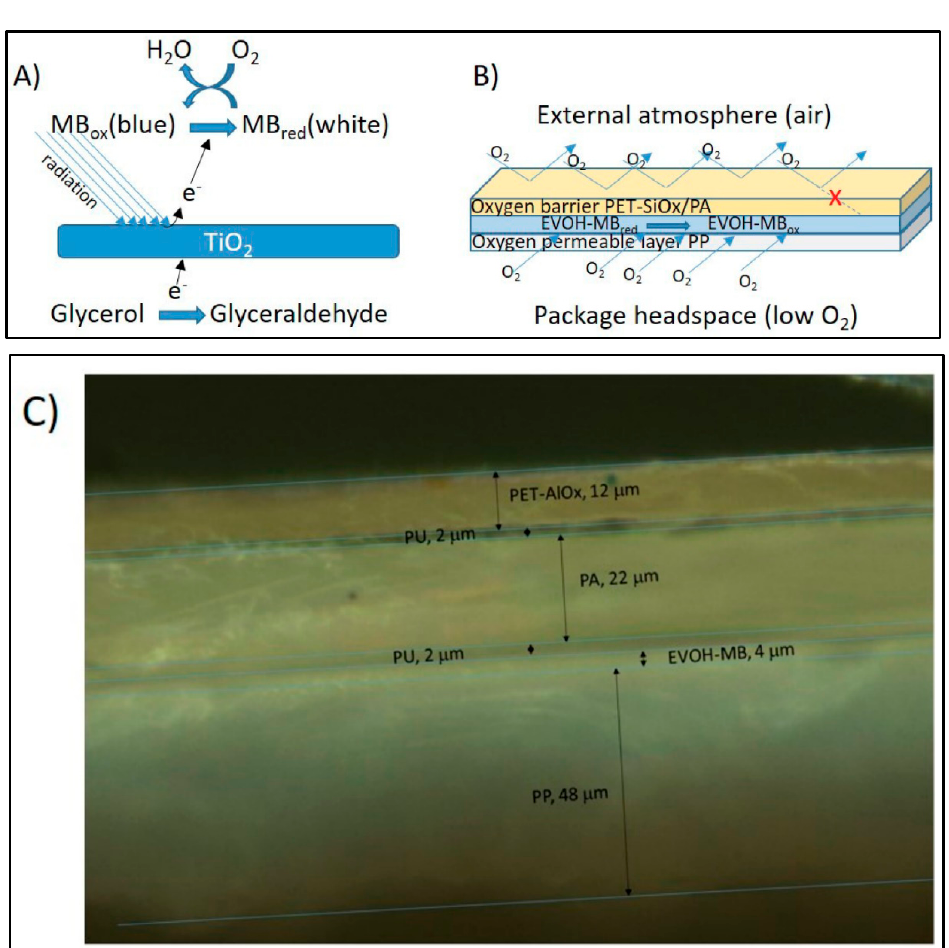
Figure 9. Schematic mechanism of O 2 detection. ( A ) Scheme of the functioning process ( B ) multilayer assembly of the sensor, and ( C ) Image of the multilayer structure of the oxygen sensor. Reprinted with permission from the reference [77]. Copyright 2019 MDPI.